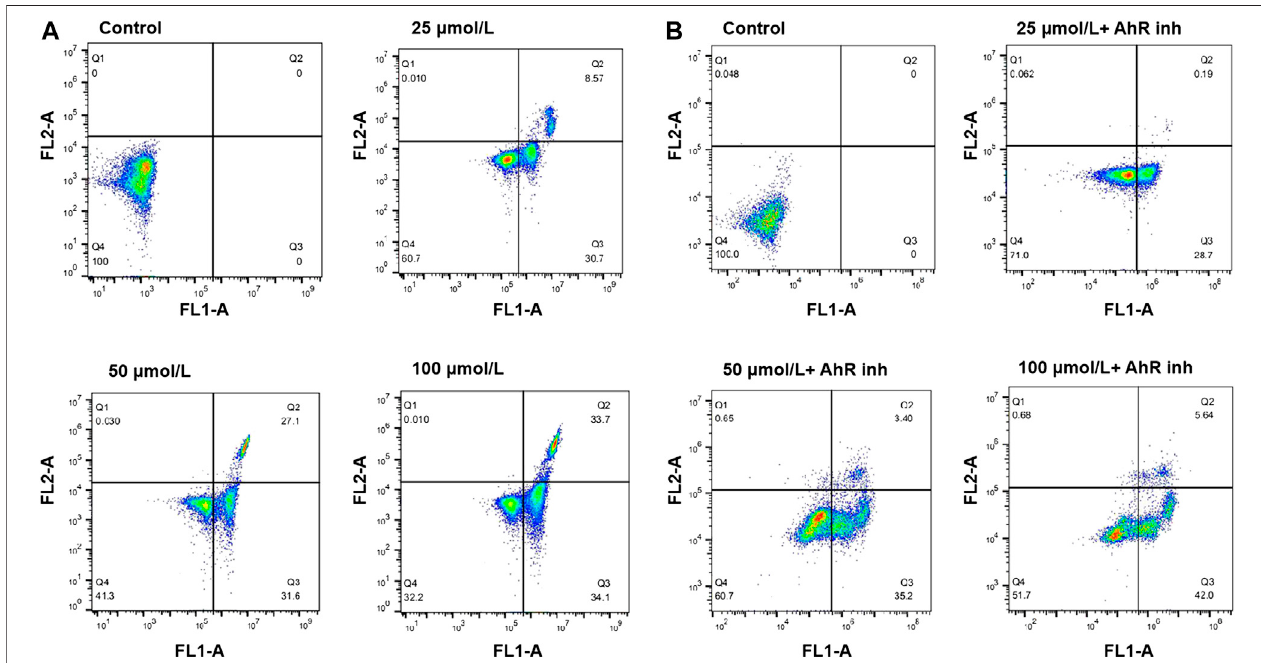
FIGURE 3 | (A) Flow cytometry analysis of apoptosis using Annexin V-FITC/PI double staining in MCF-7 cells treated with emodin at the indicated concentrations for 72 h (B) Flowcytometry analysisofapoptosis using Annexin V-FITC/PI double stainingin MCF-7 cells treated with emodin at theindicatedconcentrations or emodin with containing 10 μ mol/L of CH223191 for 72 h. The percentage of cells is shown in the respective quadrants.